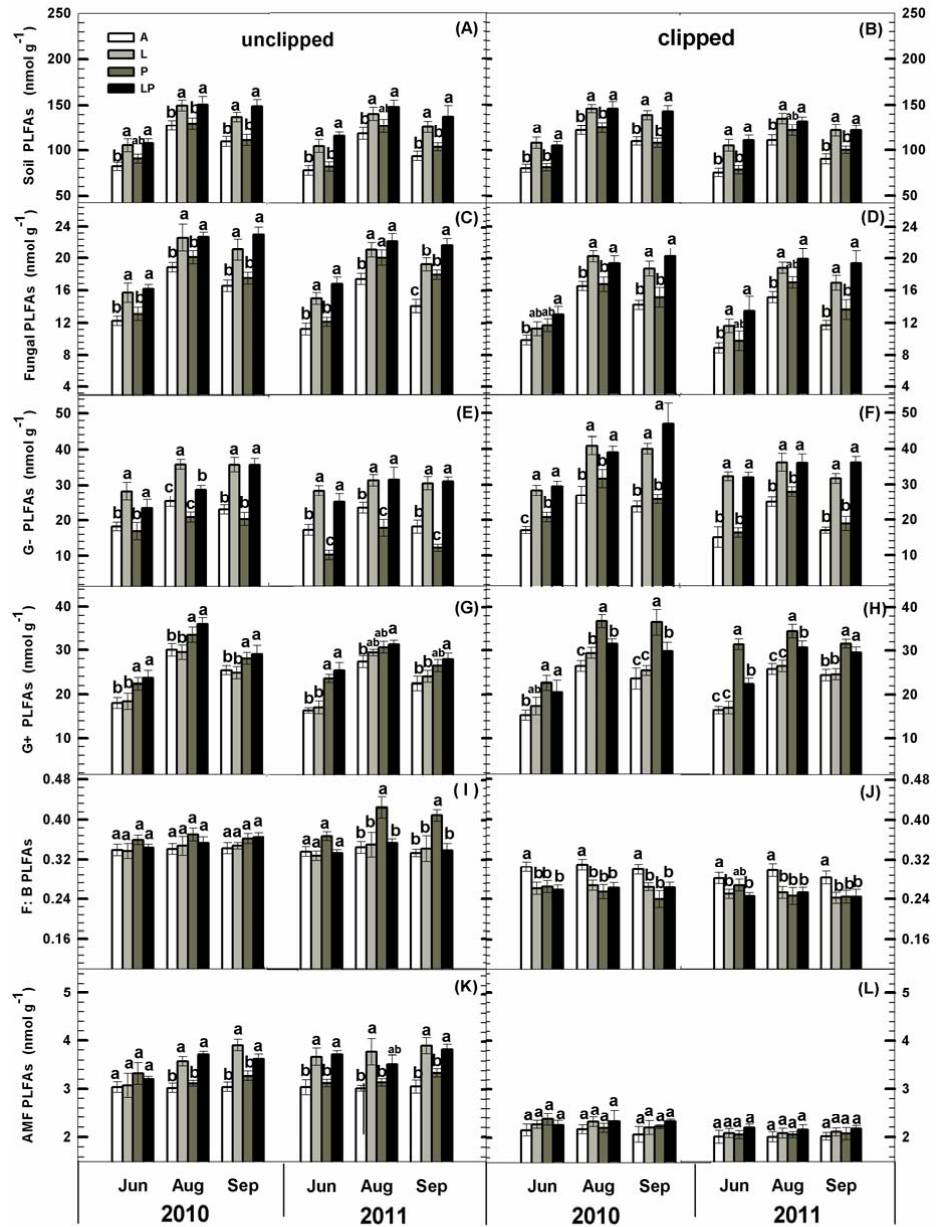
Fig. 4. The soil total phospholipid fatty acids (PLFAs), fungal PLFAs, gram-negative bacterial (G − ) PLFAs, gram-positive bacterial (G + ) PLFAs, the ratio of fungal to bacterial PLFAs (F:B) and arbuscular mycorrhizal fungi PLFAs (AMF) as influenced by belowground particu- late litter addition ( + 60%), increased precipitation ( + 30%) and clipping in the temperate steppe of northeastern China (Fig. 4A, K from Ma et al., 2012). Values show the monthly means in 2010 and 2011. Vertical bars indicate standard error of means ( n = 6). Different lowercase letters indicate statistically significant differences ( P < 0.05). See Fig. 2 for